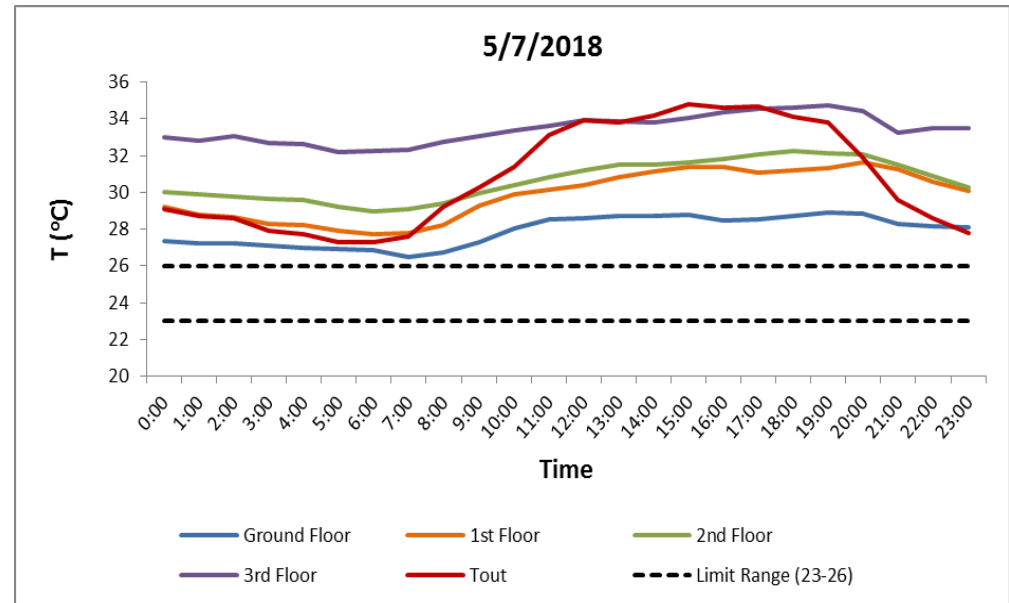
Figure 4. Monthly average RH (%) levels within the B FEPA building along with the respective limits.